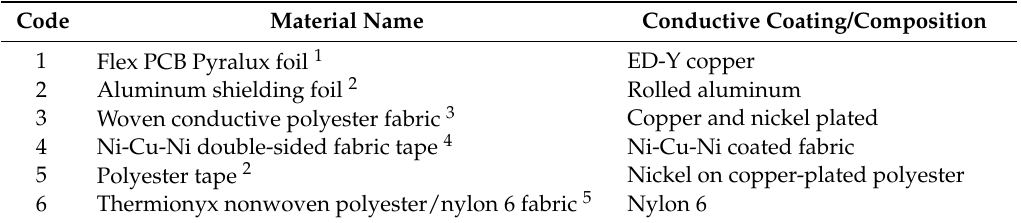
Table 1. Conductive fabric and metal foils material